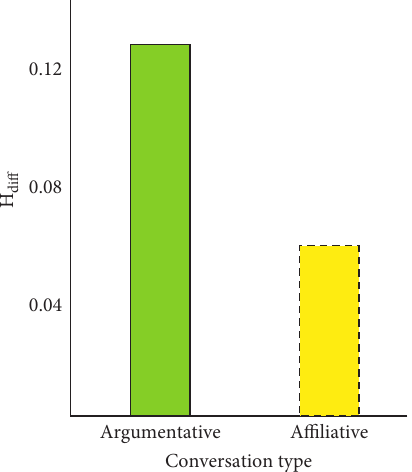
Figure 4: Dynamics of Interaction Type. Dyads having an argumentative conversation (green bar, solid line) were significantly farther apart in terms of the fractal structure of their movement than dyads having an affiliative conversation (yellow bar, dotted